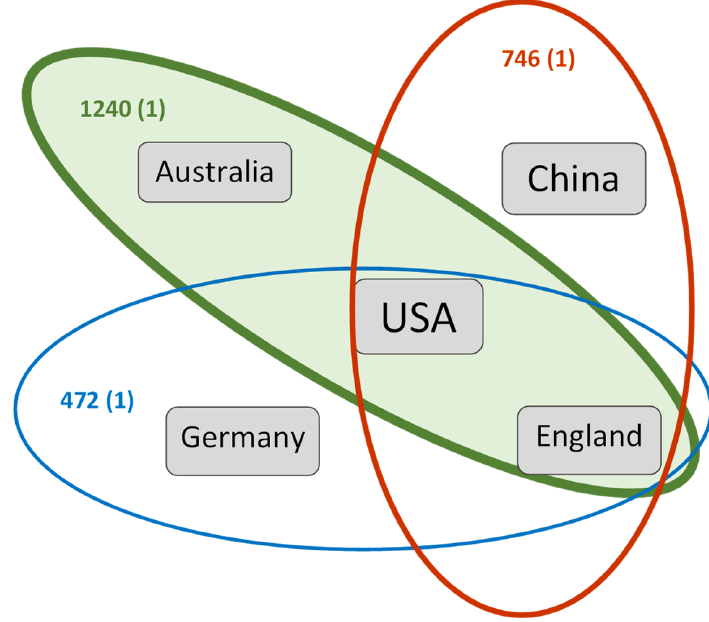
Figure 8. Role of individual countries in trilateral scientific cooperation publications.